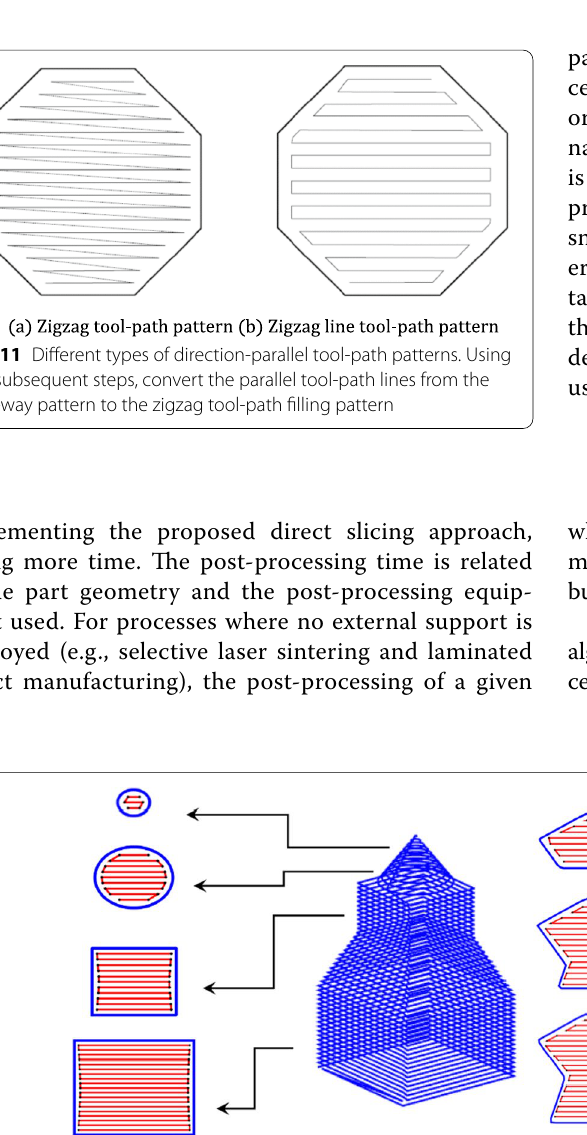
Fig. 12 Zigzag tool-paths generated by the proposed approach for different layers in both examples. Shows the examples after applying the proposed zigzag tool-path’s